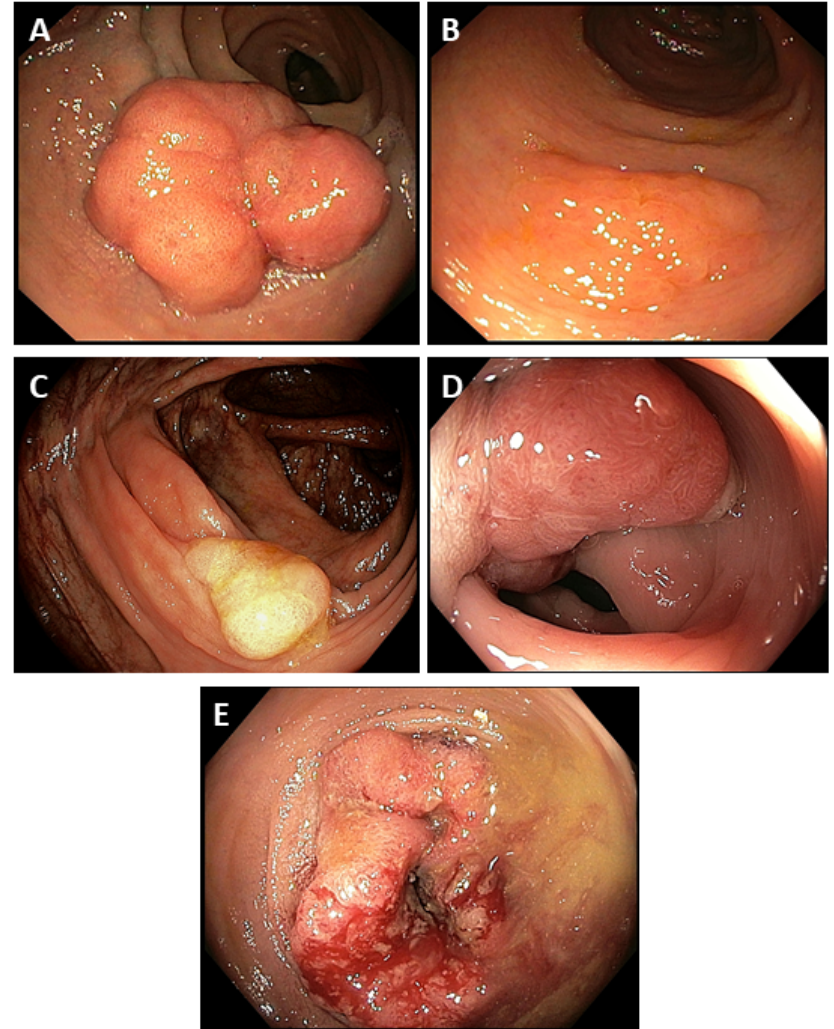
Figure 4. Selected endoscopic images of adenomas and CRC at different stages. ( A )—Tubular adenoma; ( B )—tubulo-villous adenoma; ( C )—sedentary serrated adenoma (SSA) without dysplasia; ( D )—tubular adenocarcinoma, grade 1 and ( E )—tubular adenocarcinoma, grade 2.